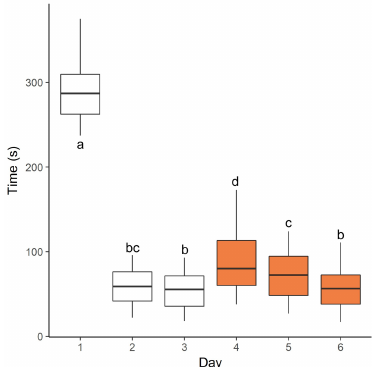
Figure 3. Boxplots showing the minimum and maximum times (whiskers), the first and third quartiles (hinges) and the median times taken for all heifers to move through the funnel structure over consecutive days of acclimation testing (days 1–6). Orange boxes indicate testing days when the traffic cone was present. Three outliers were removed from Day 1 data (timed out at 600 s). Common letters depict least square means which did not differ significantly as assessed using a multilevel linear model.